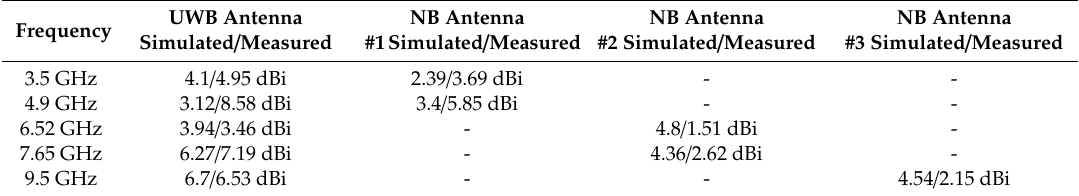
Table 2. The comparison of the simulated and measured peak gains of the proposed antennas at center resonant frequencies of the NB antennas.